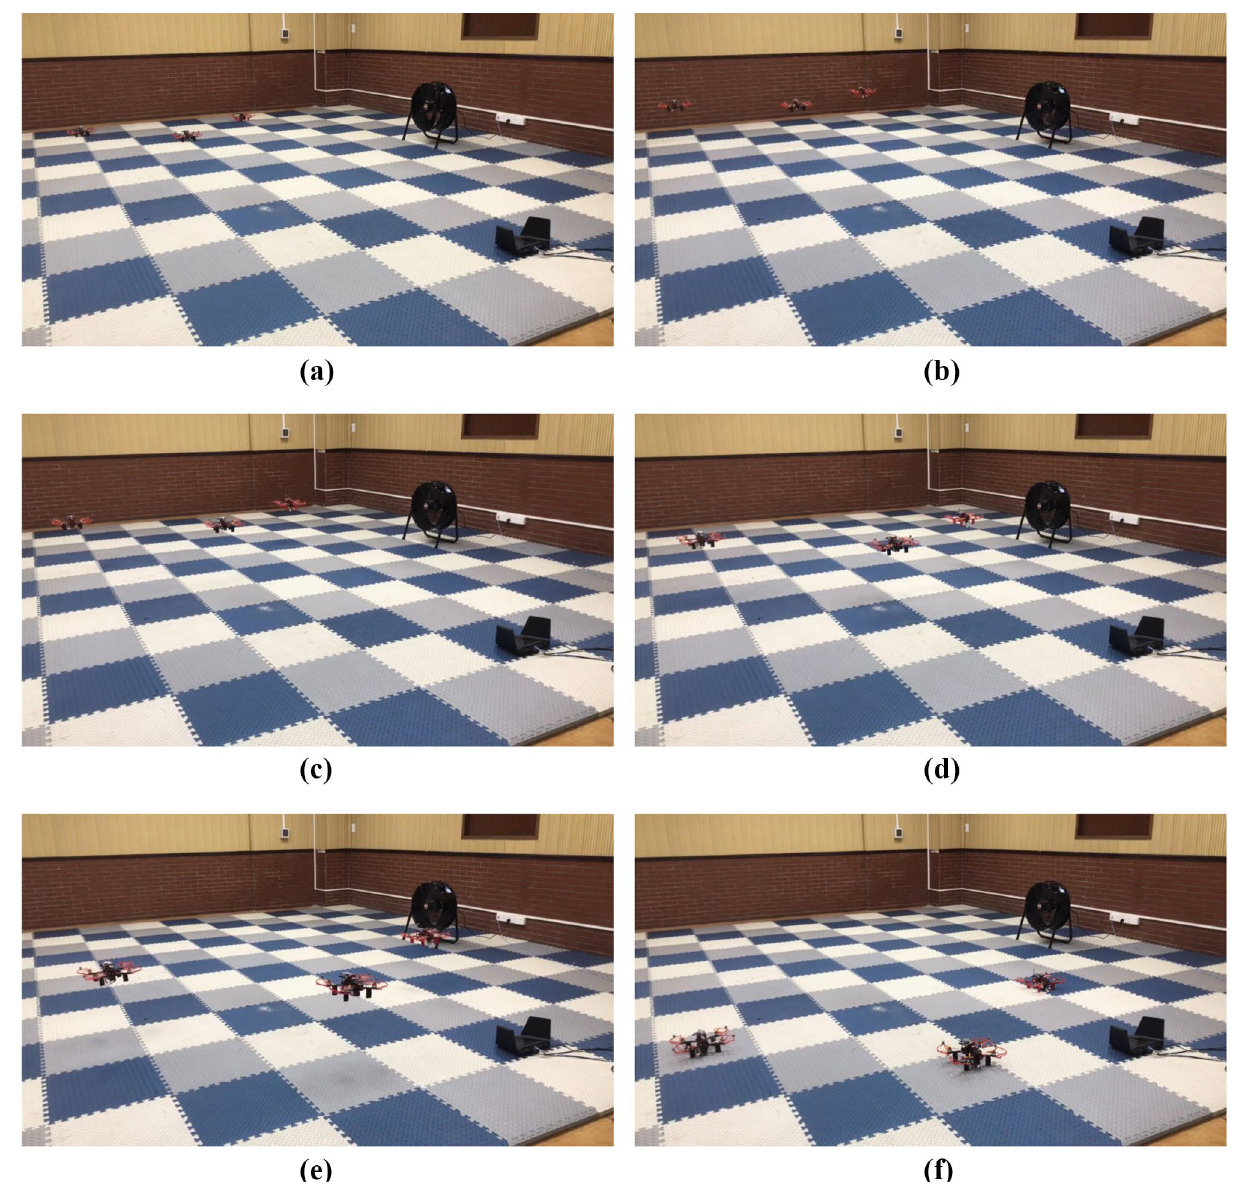
Figure 14. The experimental video image sequences ( a )–( f ) of a group of small UAVs flying in formation when faced with